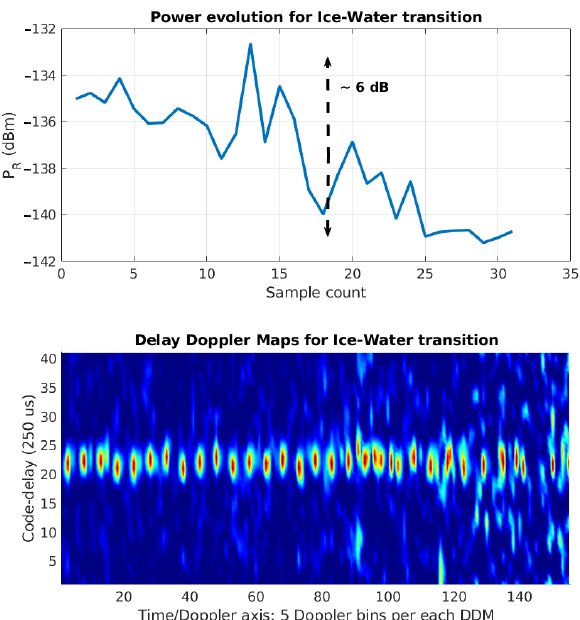
Figure 14. ( Top ) P R by FMPL-2 for the area highlighted in Figure 13, ( Bottom ) Normalized Delay- Doppler Maps (Doppler-Time and Code-Delay axis) for the highlighted